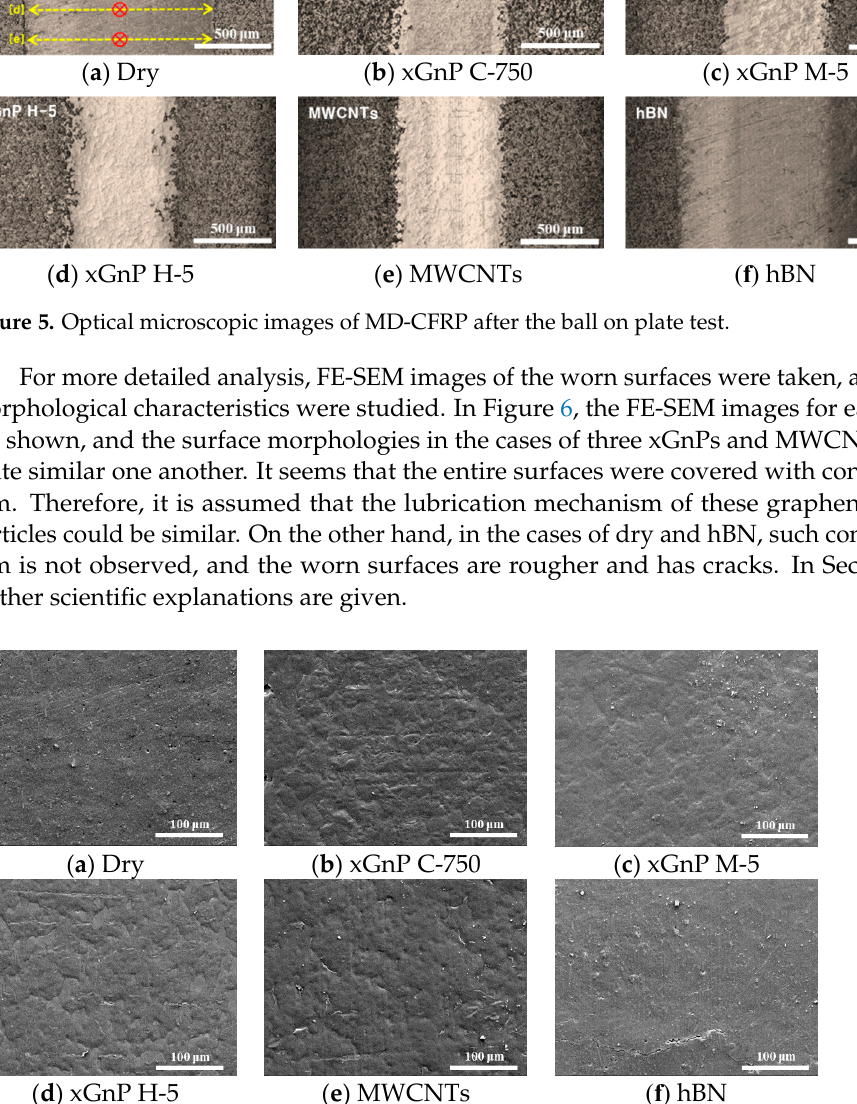
Figure 6. FE-SEM images of worn surfaces during the ball on plate test (× 300)